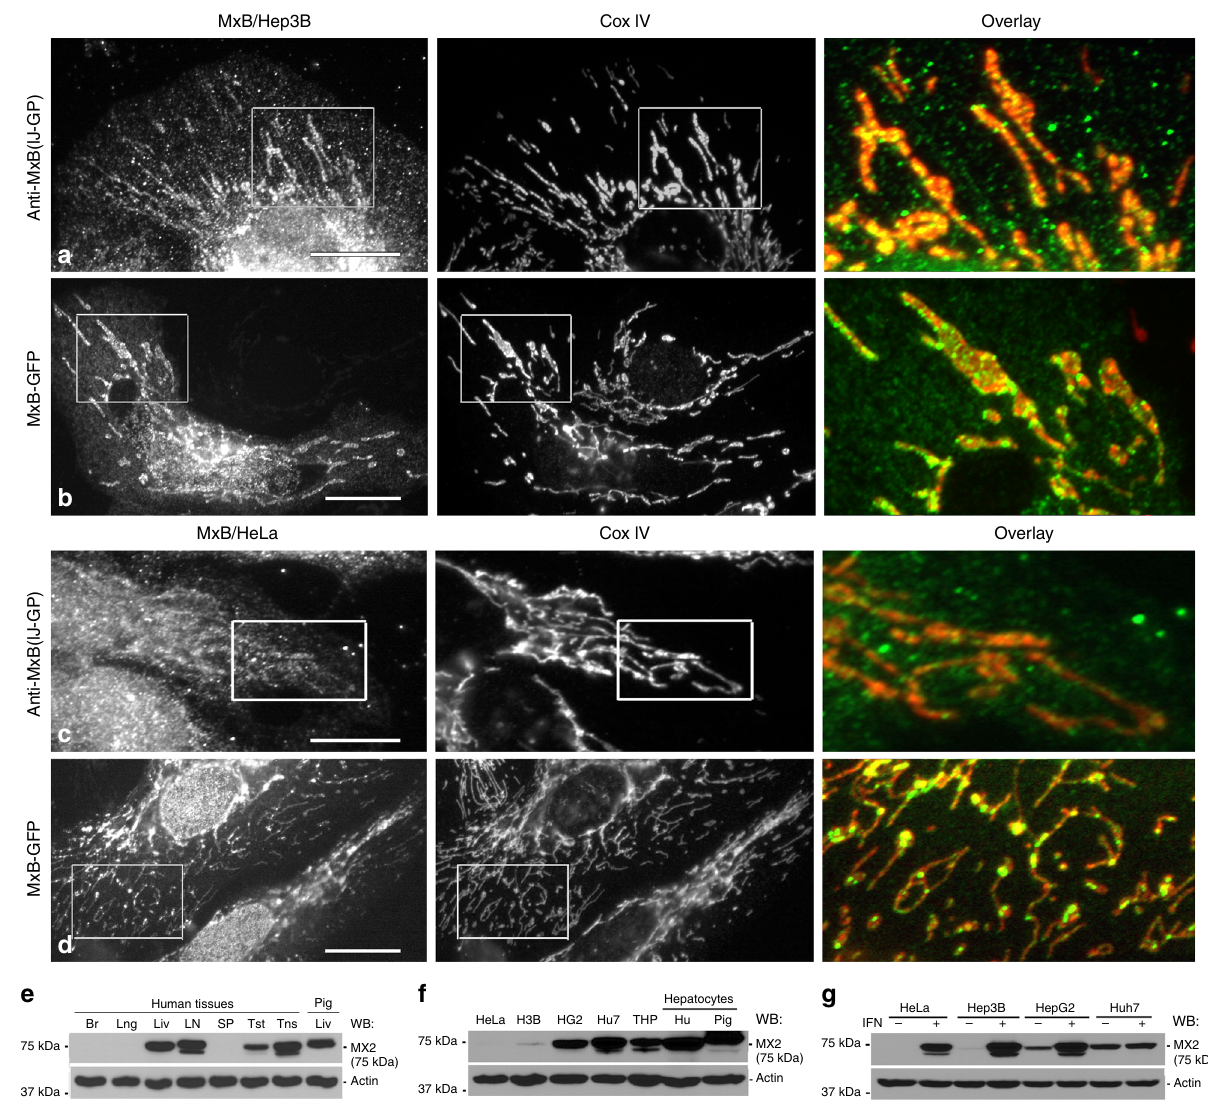
Fig. 1 MxB is localized to mitochondria in cultured cells. Fluorescence images of Hep3B cells or HeLa cells, stained with a polyclonal antibody (IJ-GP) to MxB ( a , c ), or expressing exogenous human MxB-GFP ( b , d ). All cells were stained for the inner mitochondrial membrane marker CoxIV. MxB is visualized as small or large puncta that align closely with mitochondrial membranes. Boxed regions provide a higher magni fi cation for color overlays showing the alignment of MxB (green) with mitochondria (red) in both cell types. Scale bars, 10 μ m. e Western blot analysis of different human tissues (Br = brain, Lng = lung, Liv = liver, LN = lymph node, SP = spleen, Tst = testis, Tns = tonsil) for endogenous MxB that appears enriched in the liver, lymph node, testis, tonsil, and pig liver. f Western blotting comparing MxB expression in HeLa cells, three different hepatocyte cell lines, and a human monocyte cell line (THP- 1), as well as primary human and pig hepatocytes. Expression levels are exceptionally high in primary hepatocytes, the HepG2 and Huh7 cell lines (H3B = Hep3B, HG2 = HepG2, Hu7 = Huh7, THP = THP-1, Hu = human hepatocytes). g Western blotting of four distinct cell lines comparing endogenous MxB expression under control conditions vs. treatment with 1,000 IU/ ml -1 of IFN- α − 2 Α . HeLa, Hep3B and HepG2 cells induced MxB expression by IFN treatment, but not Huh7